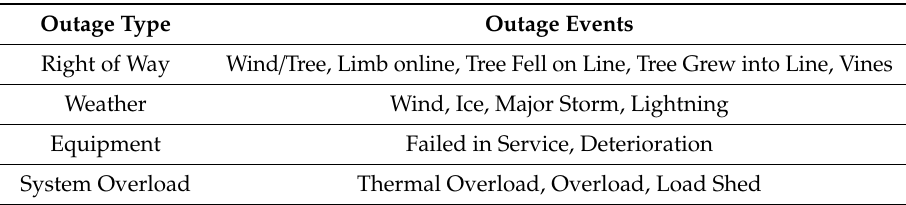
Table 1. Four types of outages and their associate